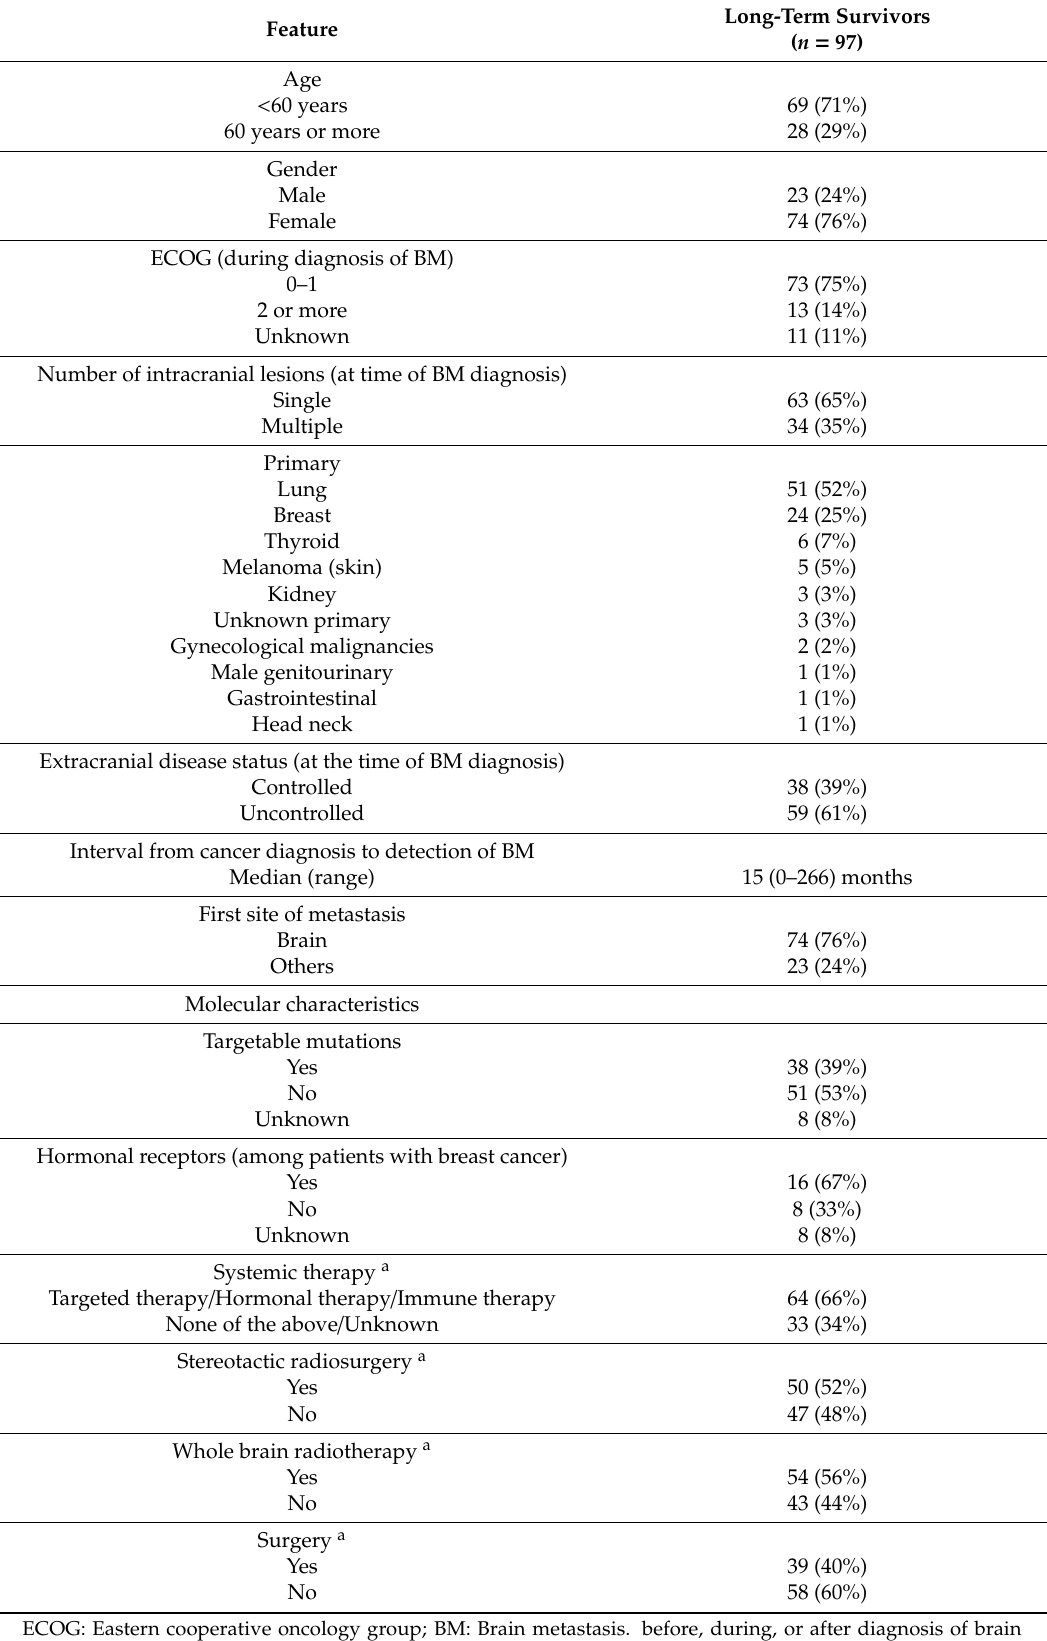
Table 1. Details of various patient, disease, and treatment characteristics in the long-term survivors.